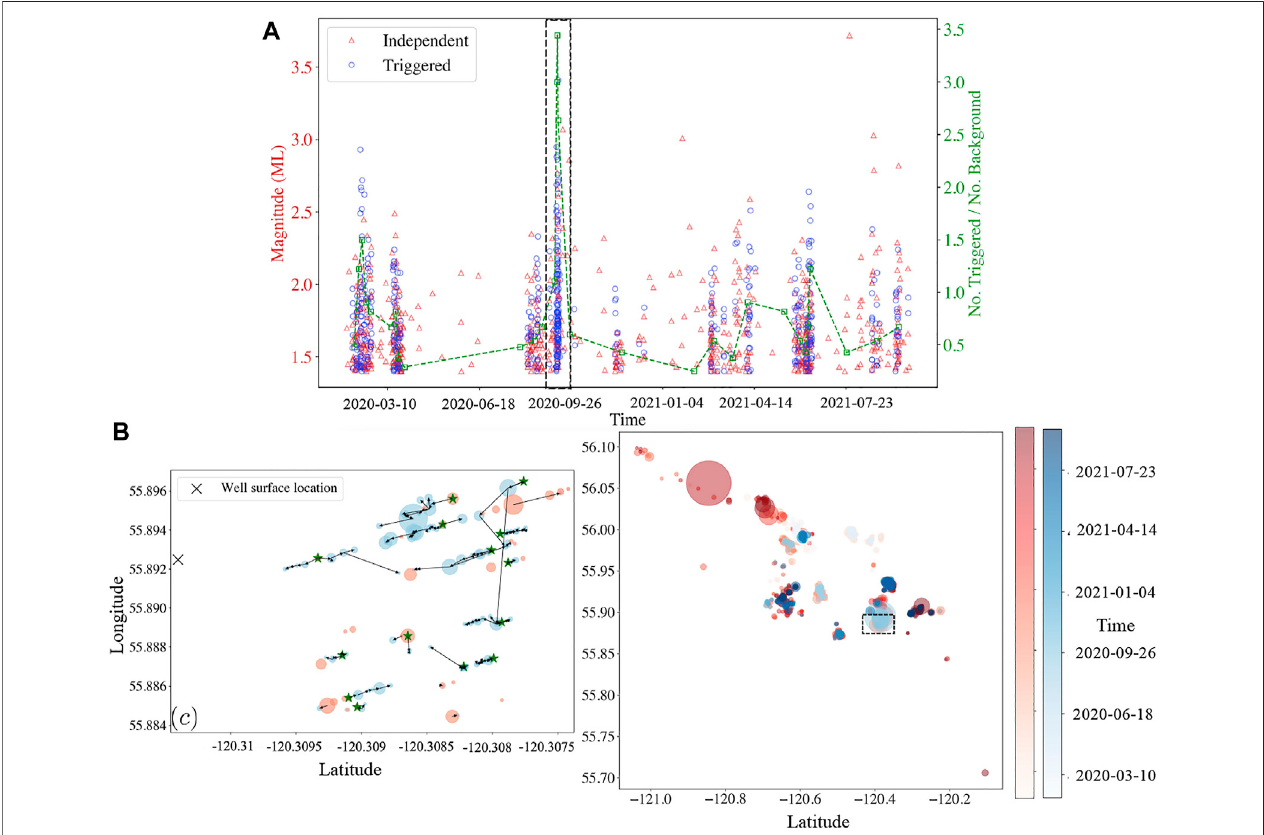
FIGURE 6 | Interevent triggering in the KSMMA catalog, where we have separated events into triggered (blue) and independent (red) events. Only events above magnitude of completeness ( m c = 1.4) are shown here. (A) Magnitude time series and the ratio of triggered to independent events over a window size of 50 events. The dashed black rectangle represents a period (September 9 – 13, 2020) with maximum triggered to independent ratio. (B) Spatial map of events. The color intensity and radius are associated with the passing of time and the size of the earthquakes, respectively. (C) Spatial map of triggering cascades associated with the period represented by the dashed black rectangle in (A) and (B) . The green stars indicate the root events of each triggering cascade where more than two events have been triggered in that